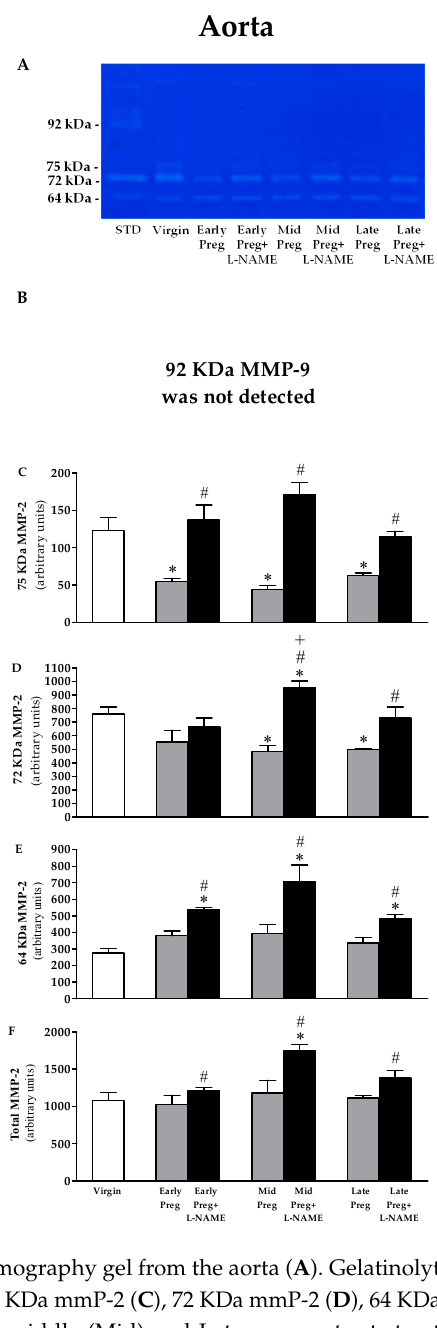
Figure 7. Representative zymography gel from the aorta ( A ). Gelatinolytic activity of 92 KDa MMP-9 was not detected ( B ), and, 75 KDa MMP-2 ( C ), 72 KDa MMP-2 ( D ), 64 KDa MMP-2 ( E ) and total MMP-2 ( F ) in virgin rats and Early, middle (Mid) and Late-pregnant rats treated with saline or L-NAME. Values represent mean ± SEM. * P < 0.05 versus the Virgin group, # P < 0.05 versus respective Early-Preg, Mid-Preg and Late-Preg groups, + P < 0.05 versus the respective Early-Preg group.